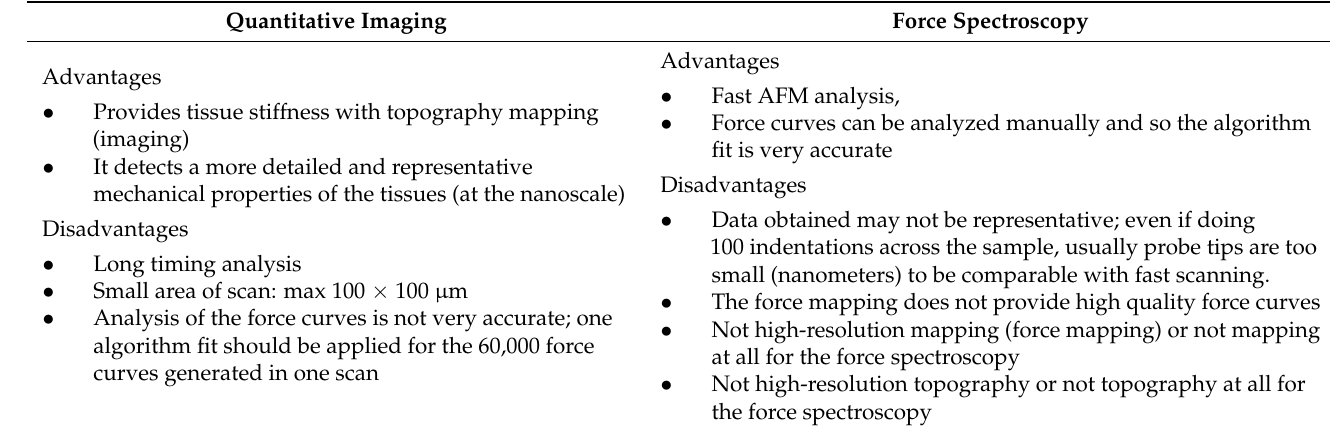
Table 1. General comparison between fast scanning and force spectroscopy